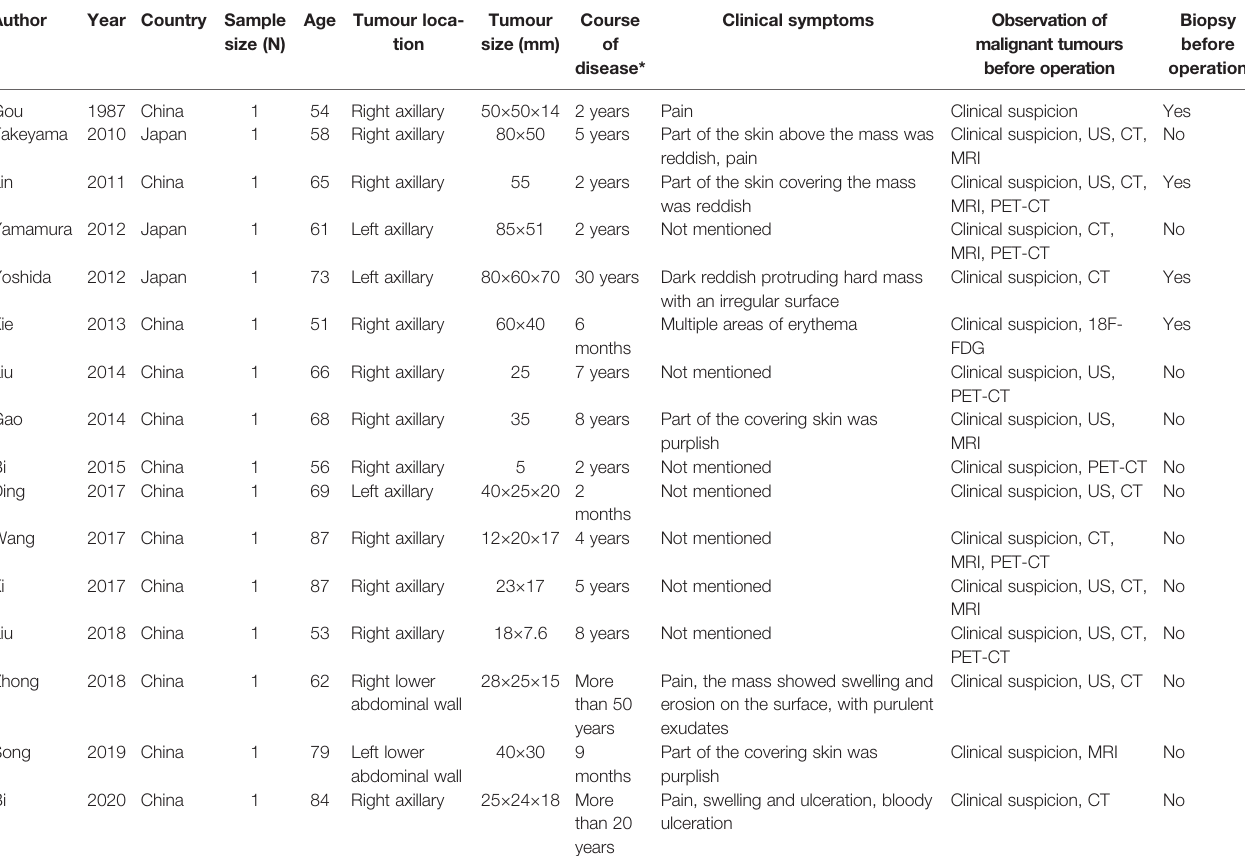
TABLE 1 | Tumor characteristics in the included